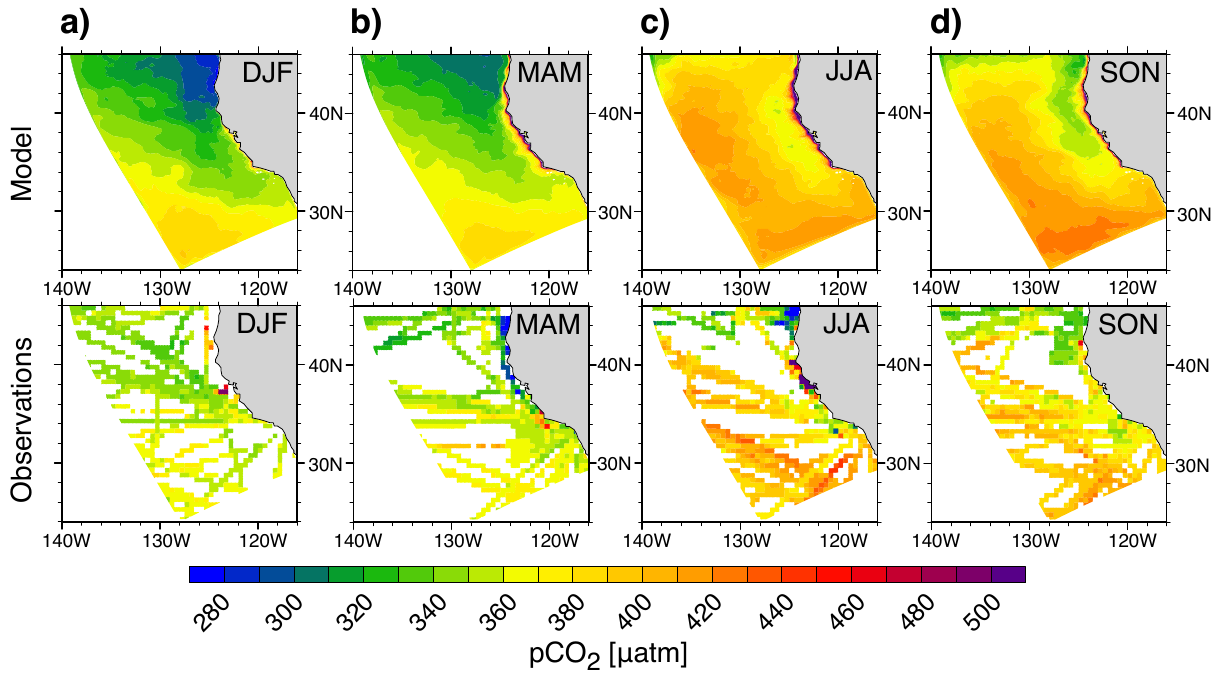
Fig. 2. Seasonally averaged modeled (upper row) and observed (lower row) surface p CO 2 for winter ( a ; DJF), spring ( b ; MAM), summer ( c ; JJA) and fall ( d ; SON). Observations are p CO 2 computed from the Surface Ocean CO 2 Atlas (SOCAT Version 2; Pfeil et al., 2013), the global surface p CO 2 database (Takahashi et al., 2013) and the MBARI/CalCOFI Line 67 (Collins et al., 2003). The data were first binned to 0.5 ◦ × 0.5 ◦ grid boxes to compute a climatology, normalized to the year 2000 and then regridded to match the ROMS grid. The lower row shows all the grid boxes with observations in them, i.e. before we applied our elimination